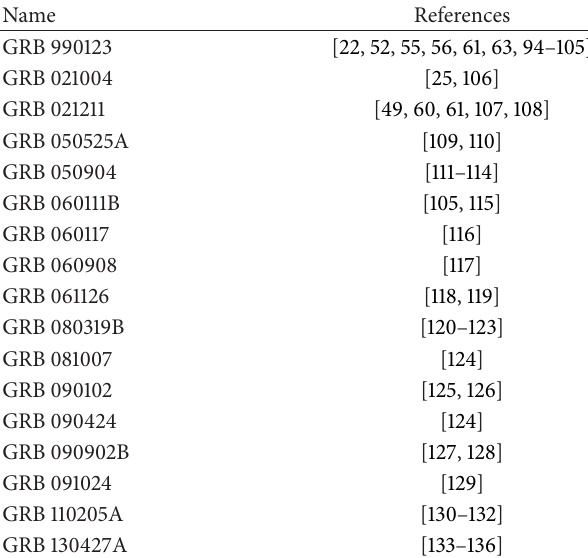
Table 1: GRBs with claimed reverse shock signatures and the corresponding